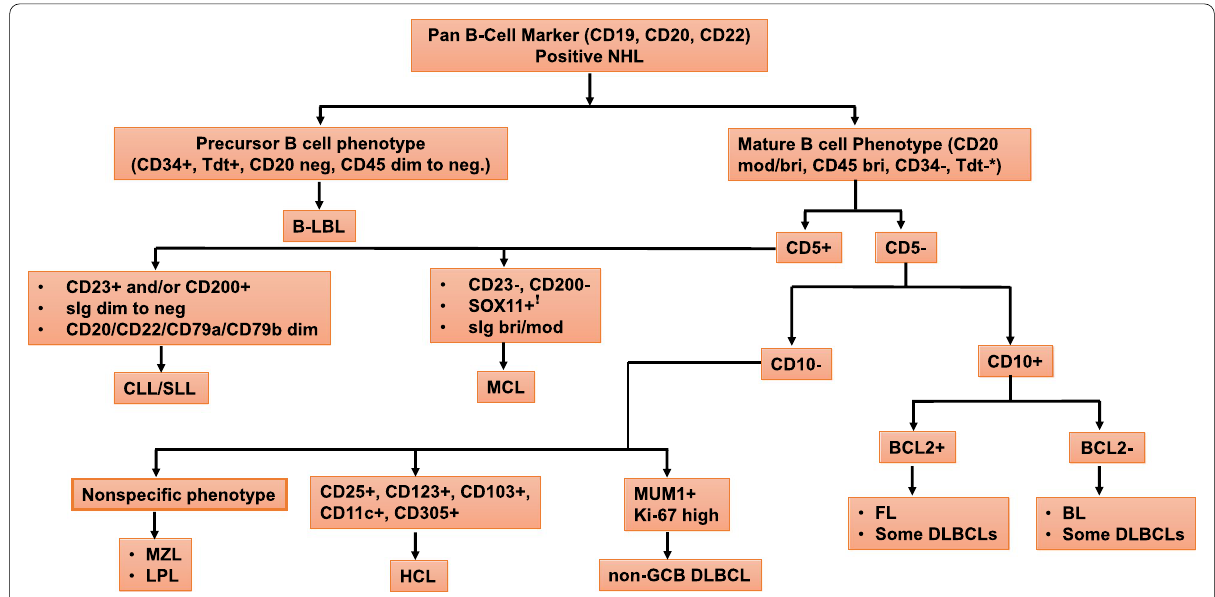
Fig. 2 Schematic representation of immunophenotyping-based approach in mature B-cell